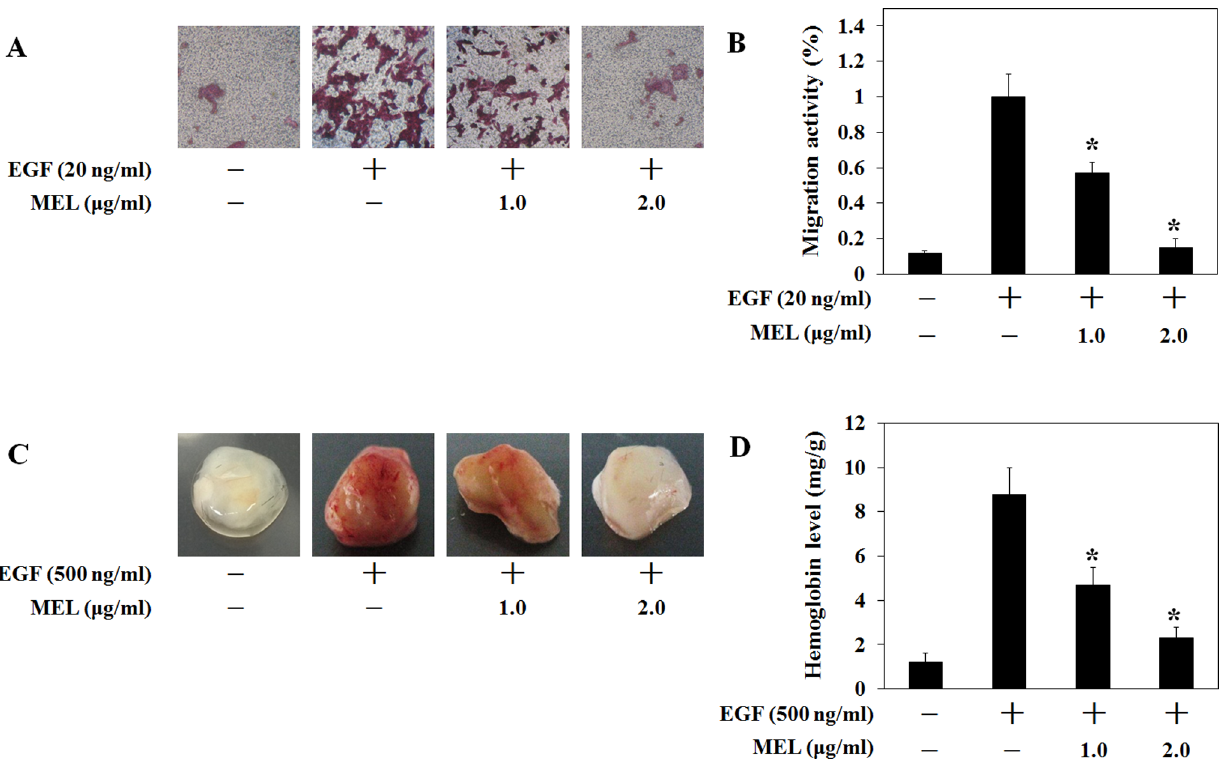
Figure 5. Melittin (MEL) suppressed the EGF-induced migration and angiogenesis in the CaSki cells. (A and B) CaSki 3 6 10 4 cells/ml were mixed with 0.5 ml of Matrigel in the presence or absence of EGF (500 ng/ml) and MEL (1 and 2 m g/ml) in vivo. (C and D) Matrigel migration assay was carried out MEL (1 and 2 m g/ml) in the presence of EGF (20 ng/ml). After 24 h incubation, cells bottom side of filter were fixed, stained and counted. Data represents the means 6 SD of three independent experiments. *, p , 0.05 as compared to EGF-treated control. Results were analyzed using one- way ANOVA.